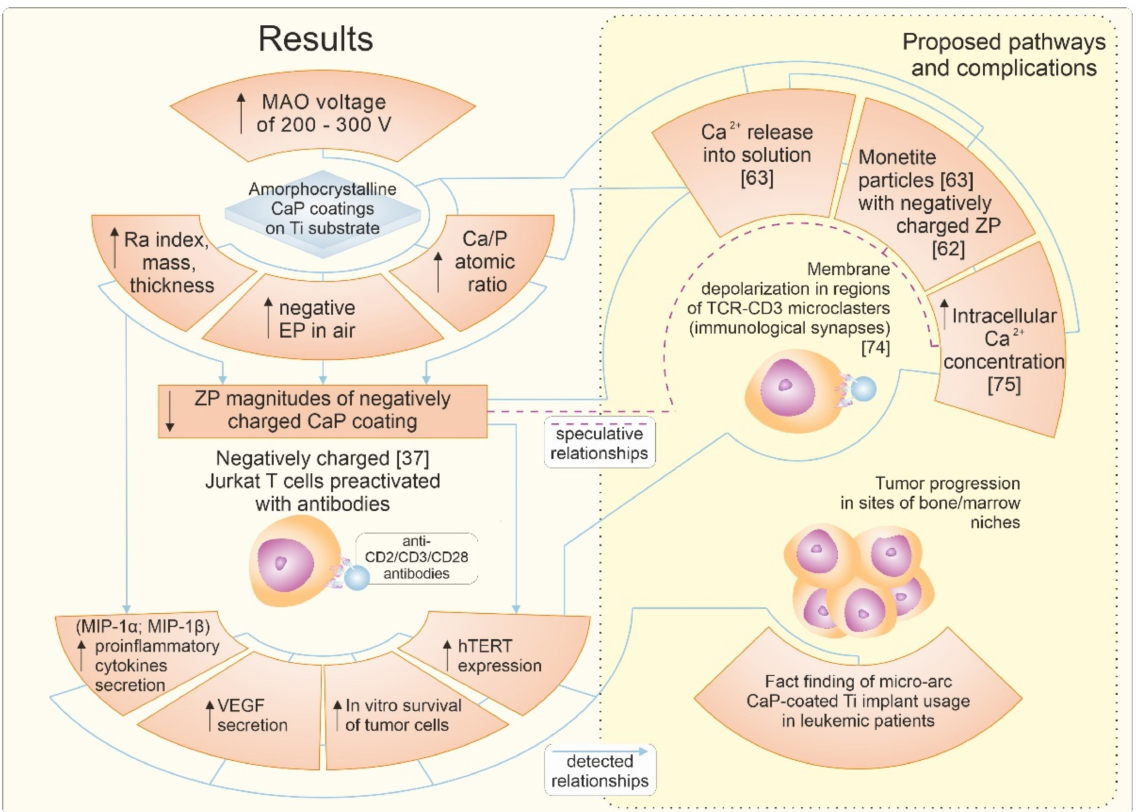
Figure 6. Results and possible Jurkat T cell behavior pathways in conditions of 14-day in vitro costimulation with anti- CD2/CD3/CD28 antibodies and rough micro-arc CaP-coated Ti